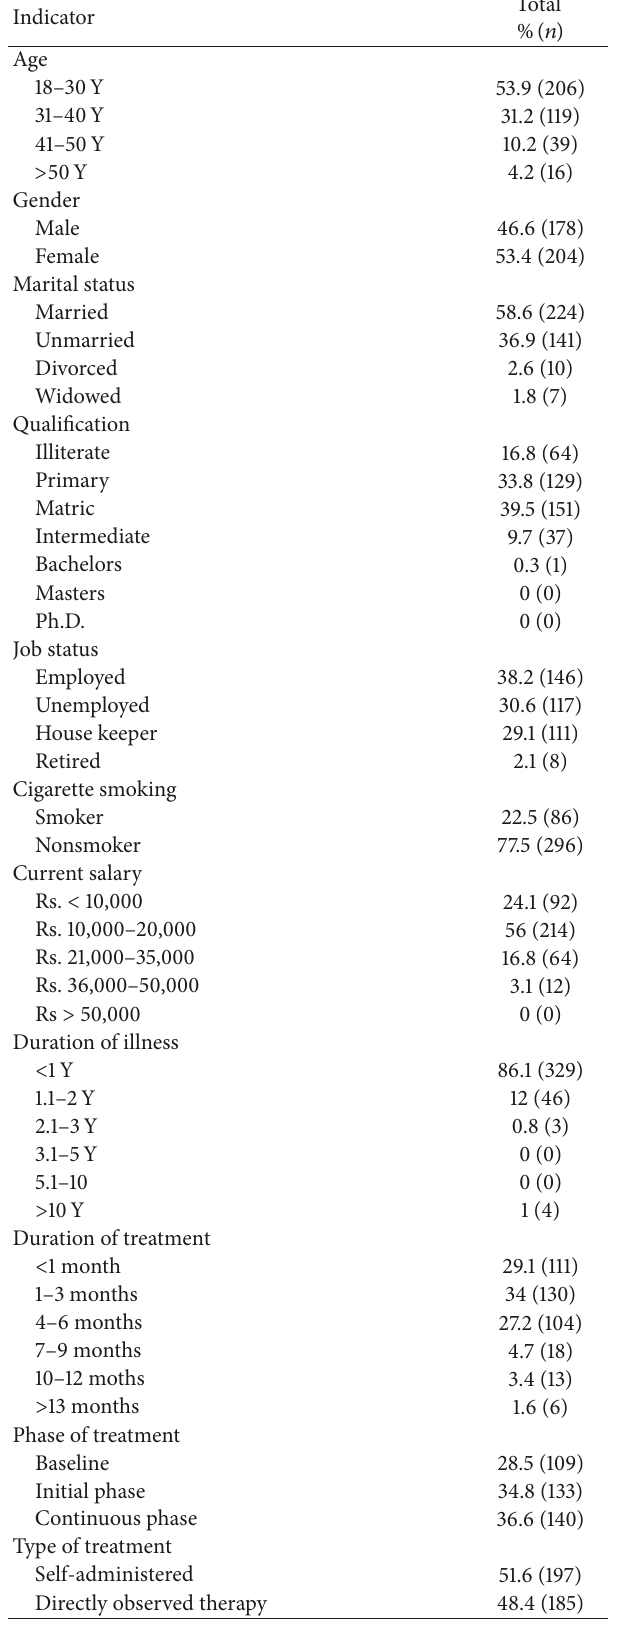
Table 1: Demographic